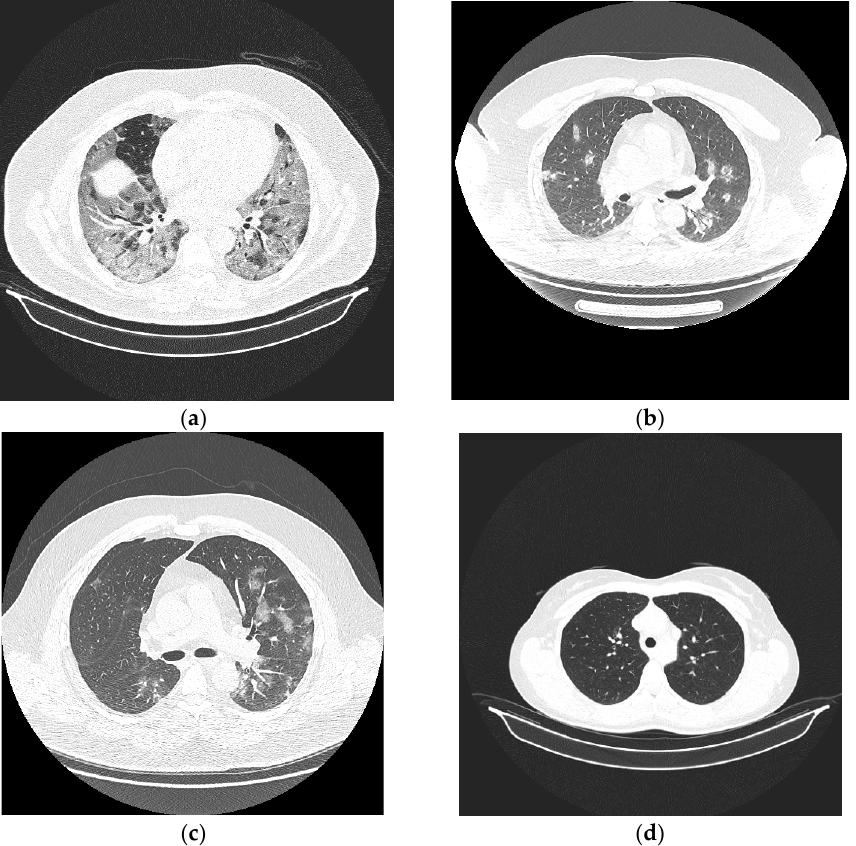
Figure 2. The evolution stages of COVID-19 infection in lungs. ( a ) Severe, ( b ) Moderate, ( c ) Mild, ( d ) Normal.